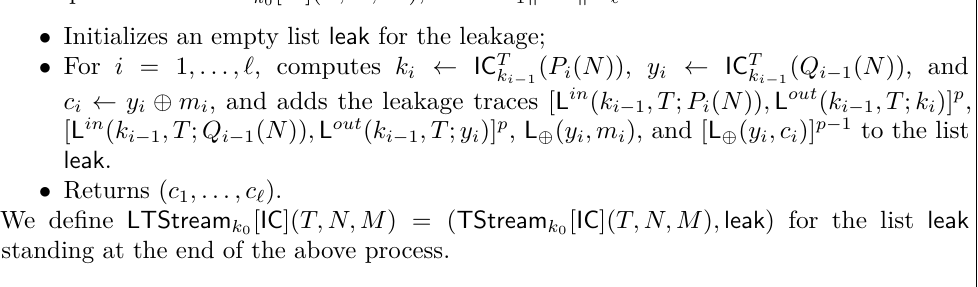
Figure 8: The real stream cipher TStream k